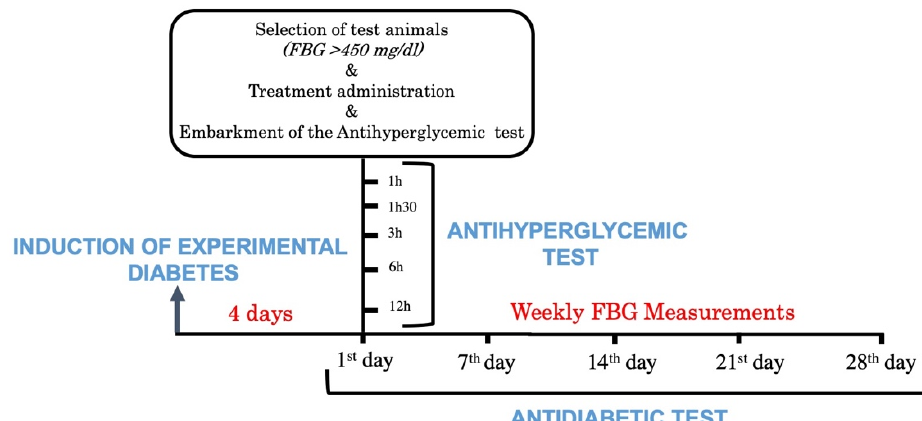
Figure 1. Experimental design .